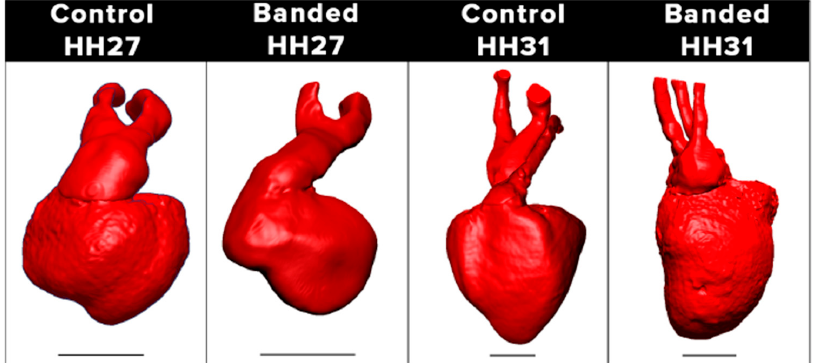
Figure 12. Reconstructed anatomies of chicken embryo hearts and the great arteries at HH27 and HH31 from 3D microCT scans. The images compare the septation of the OFT, with both stages showing separation of pulmonary and aortic outflows. Abnormal outflow positioning is observed in banded hearts at HH27 and HH31. Banded HH27 heart was captured at a side angle to better view the OFT, which exits the heart at a different angle than the control heart. Differences in the position of great arteries are more prevalent at HH31. Scale bars are 1 mm.